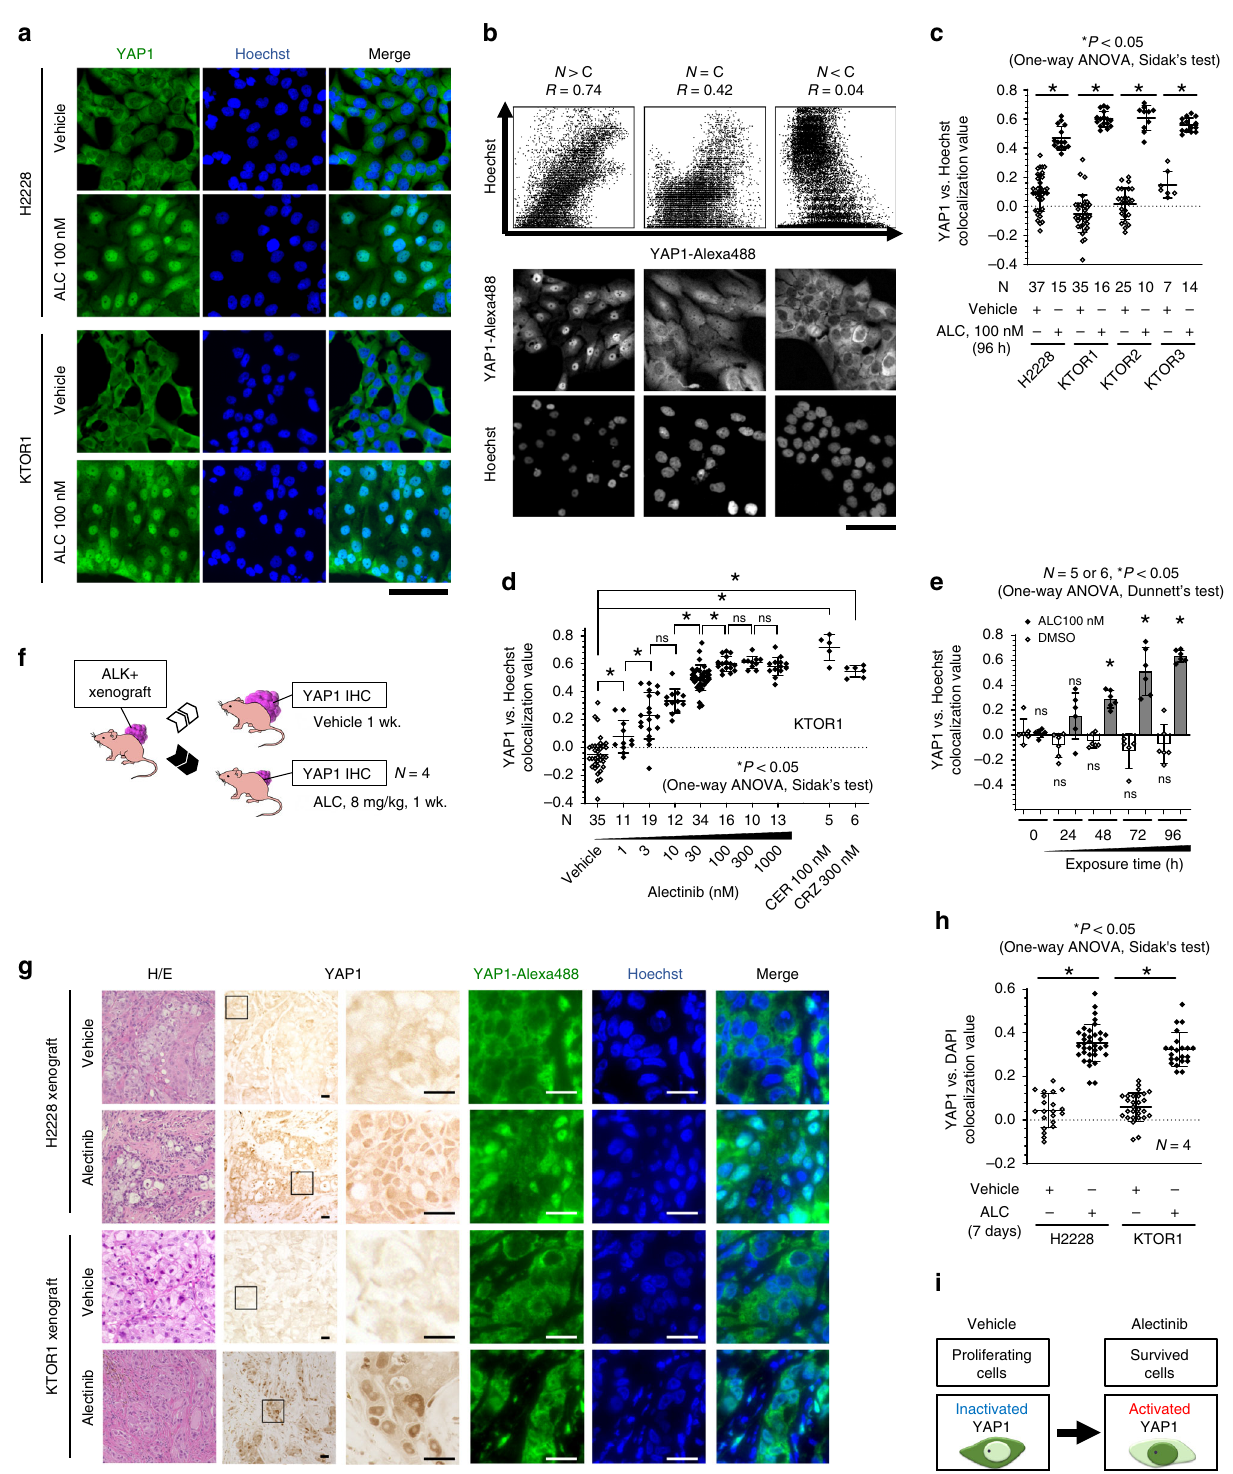
Immunoprecipitated DNA with the YAP1 antibody was sig- ni fi cantly enriched with upstream regions of both the MCL1 and BCLXL genes in ALC-treated KTOR1 cells (Fig. 6h), which con fi rmed the presence of YAP1/TEAD binding sites in the MCL1 and BCLXL upstream regions and increased binding induced by the ALC treatment. Activated YAP1 increased